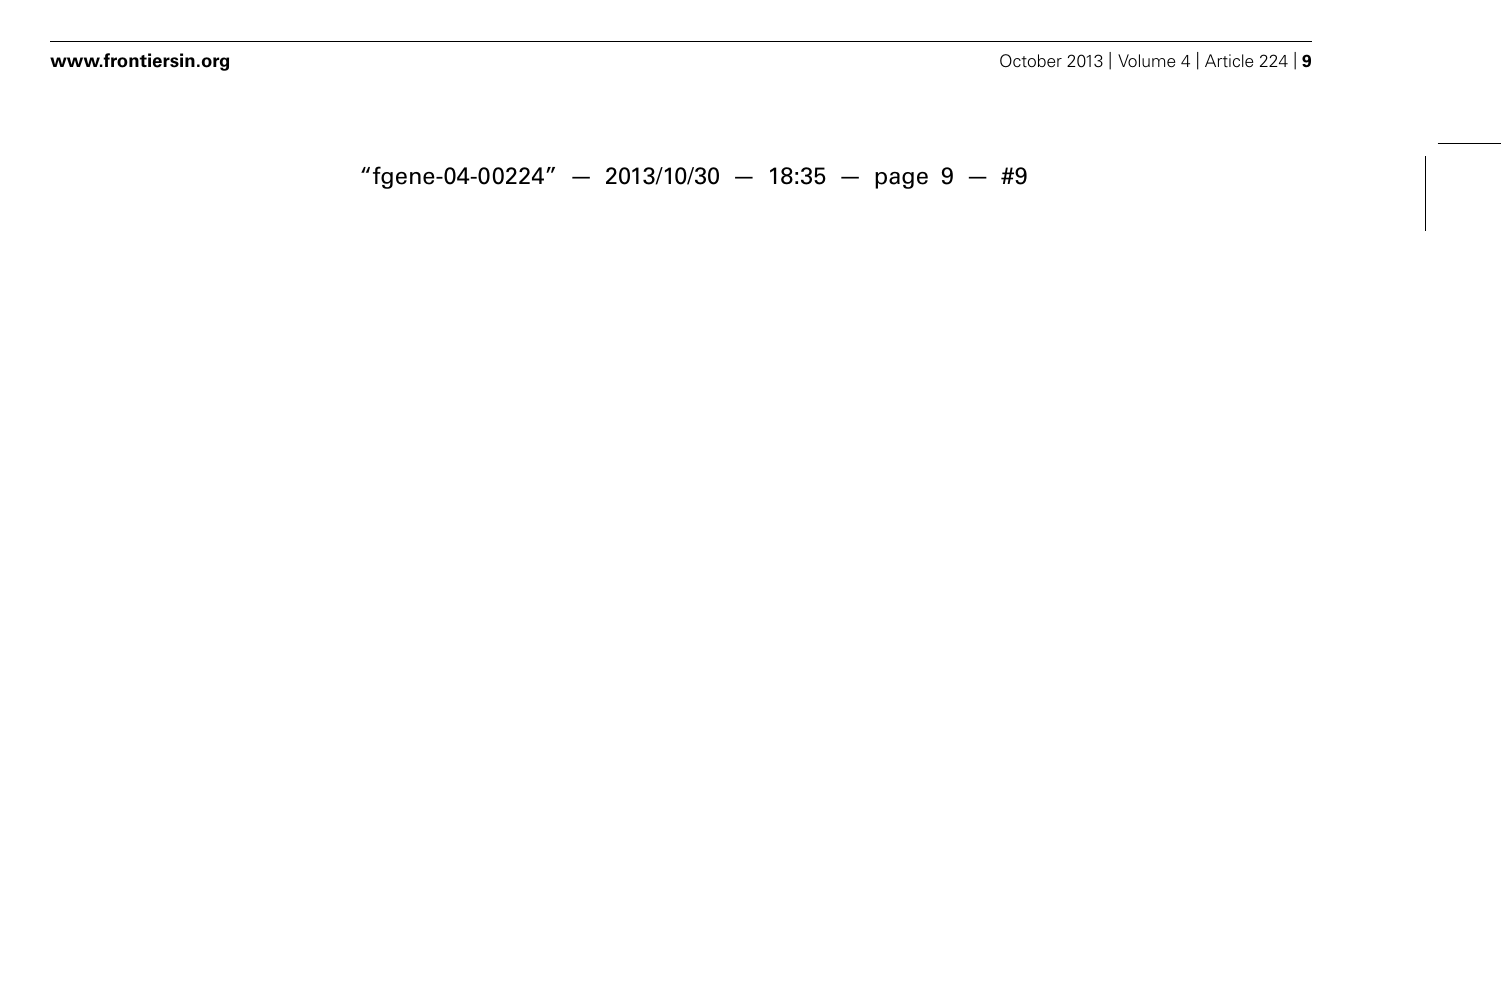
knockout; OW, older wild type; OK, older knockout without liver tumor; OKL, the normal liver portion of tumor bearing livers of KO; OKT, the tumor portion of tumor bearing livers of KO. * p < 0.05, compared between wild type of same age; α p < 0.05, compared between middle and older mice of same genotype; β p < 0.05, compared between normal liver portion and tumor portion of tumor bearing livers of knockouts of same age. n =